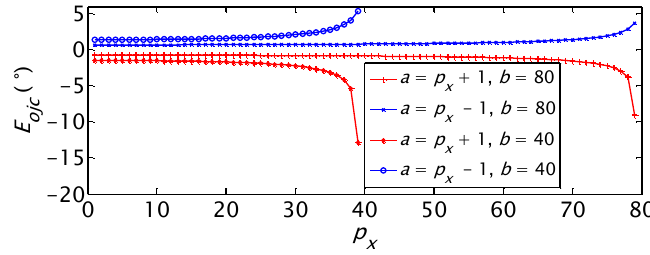
Figure 9. The relationship between O jc detection error and real horizontal pixels p x .